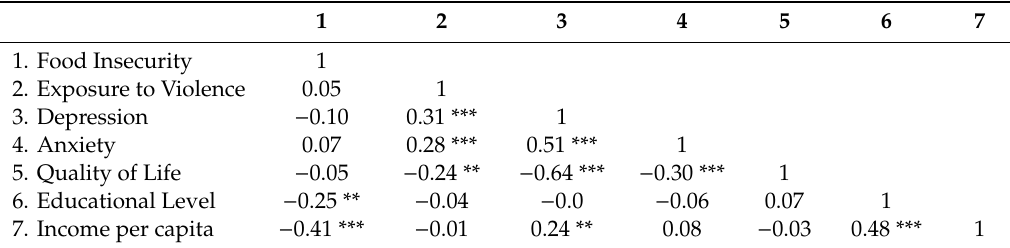
Table 2. Spearman bivariate correlations.